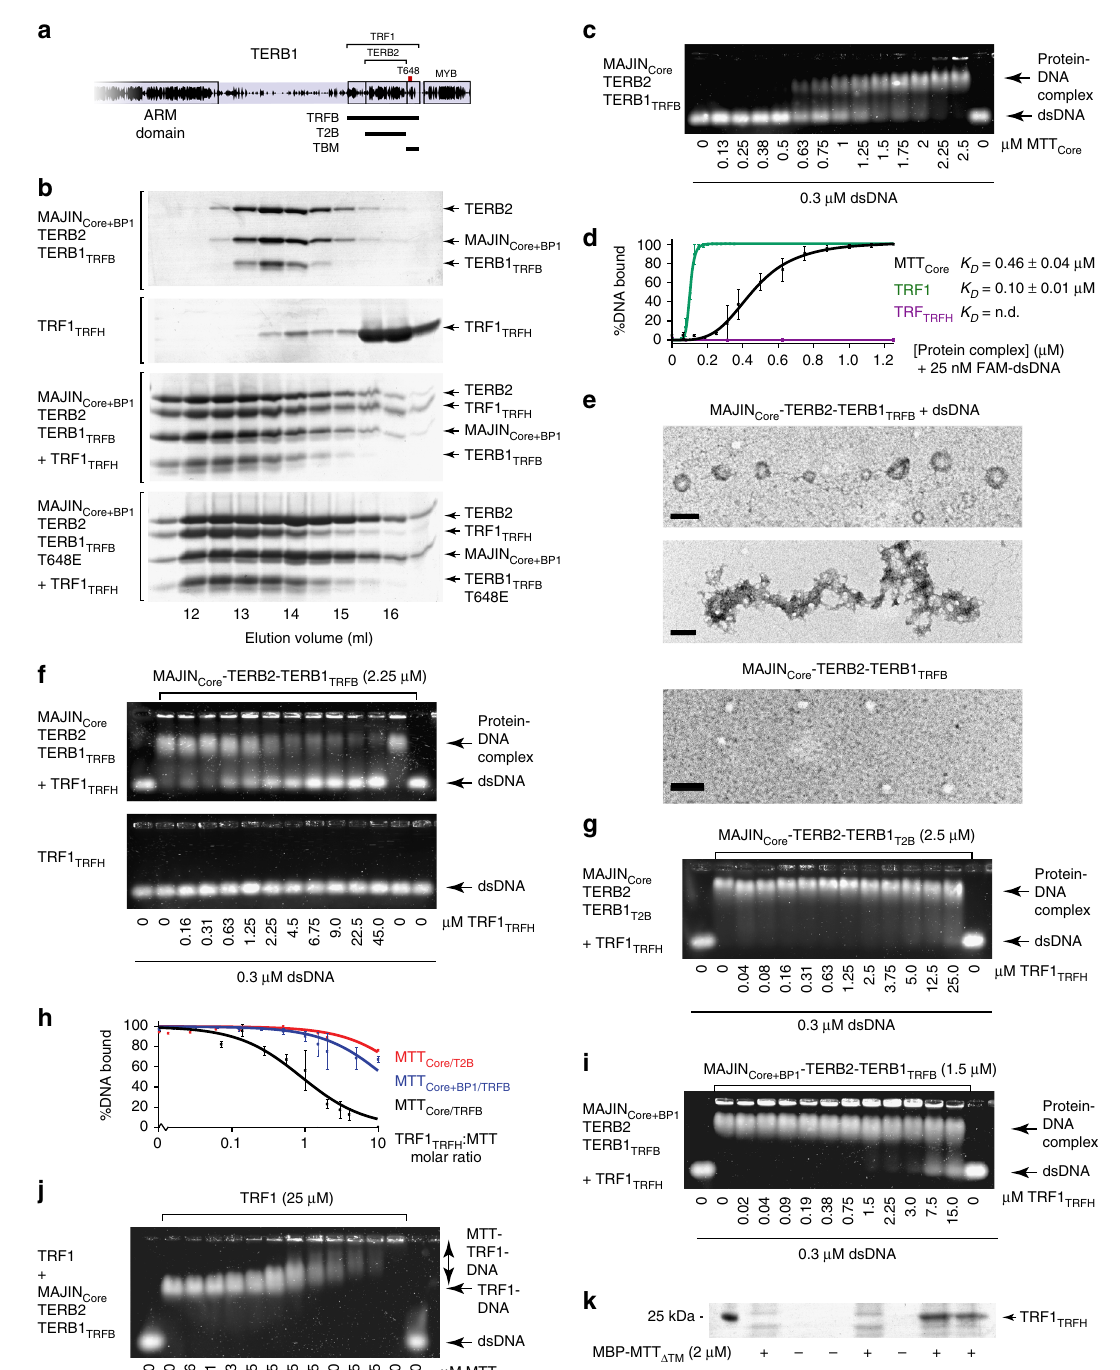
Circular dichroism spectroscopy . Far UV circular dichroism (CD) spectroscopy data were collected on a Jasco J-810 spectropolarimeter (Institute for Cell and Molecular Biosciences, Newcastle University). Buffer subtracted CD spectra were recorded using a 0.2mm pathlength cuvette (Hellma) in 10 mM Na 2 HPO 4 / NaH 2 PO 4 pH 7.5, 250mM NaF between 260 and 185 nm. Data were collected at 20nm min − 1 with a pitch of 0.2 nm, smoothed with a response time of 4s and plotted as mean residue ellipticity ([ θ ]) (x1000 deg.cm 2 .dmol − 1 .residue − 1 ). The CDSSTR algorithm of the Dichroweb server (http://dichroweb.cryst.bbk.ac.uk) was utilised to estimate secondary structure content of analysed samples. Protein sta- bility was assessed through thermal denaturation in 20 mM Tris pH 8.0, 250 mM KCl, 2mM DTT using a 1 mm pathlength quartz cuvette (Hellma). Data were recorded at 222 nm, between 5°C and 95°C at 2 °C per min every 0.5 °C, and were